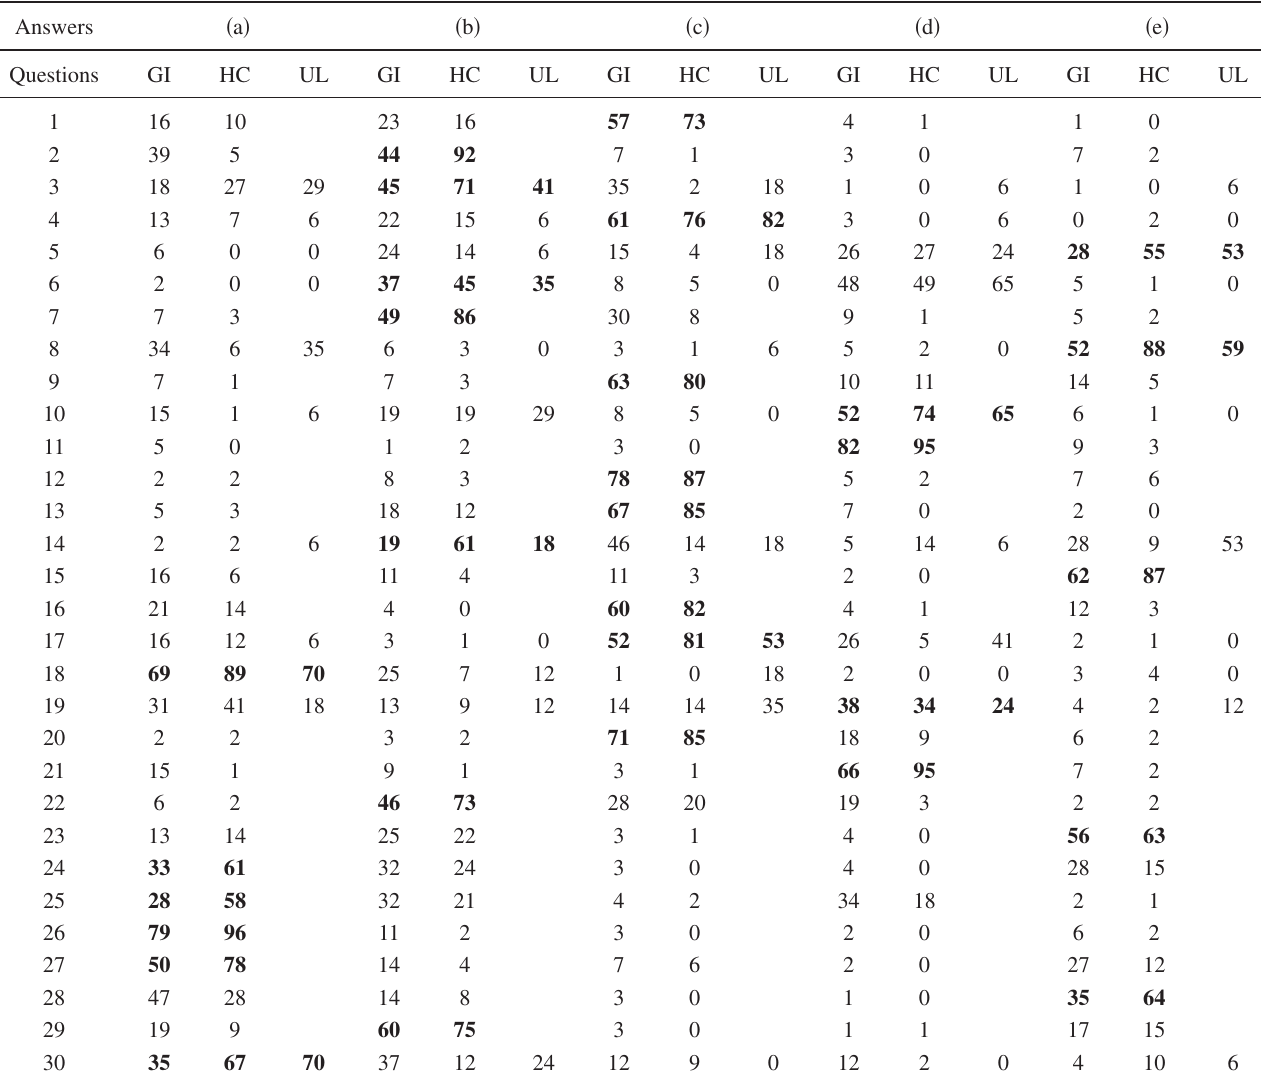
TABLE II. Multiple-choice questions (cid:1) included in Appendix B (cid:2) were administered to a total of 669 students. The performance of 559 general (cid:1) calculus- and algebra-based (cid:2) introductory nonhonor students (cid:1) GI (cid:2) is distinguished from an honor class (cid:1) HC (cid:2) of 93 introductory students, and an upper-level (cid:1) UL (cid:2) class of 17 physics majors enrolled in an intermediate mechanics course (cid:1) who were administered a subset of 11 questions (cid:2) . The table presents the average percentage (cid:1) rounded to the nearest integer (cid:2) of students selecting the answer choices (cid:1) a (cid:2) – (cid:1) e (cid:2) for each question of the test (cid:1) bold numbers refer to the correct responses (cid:2)